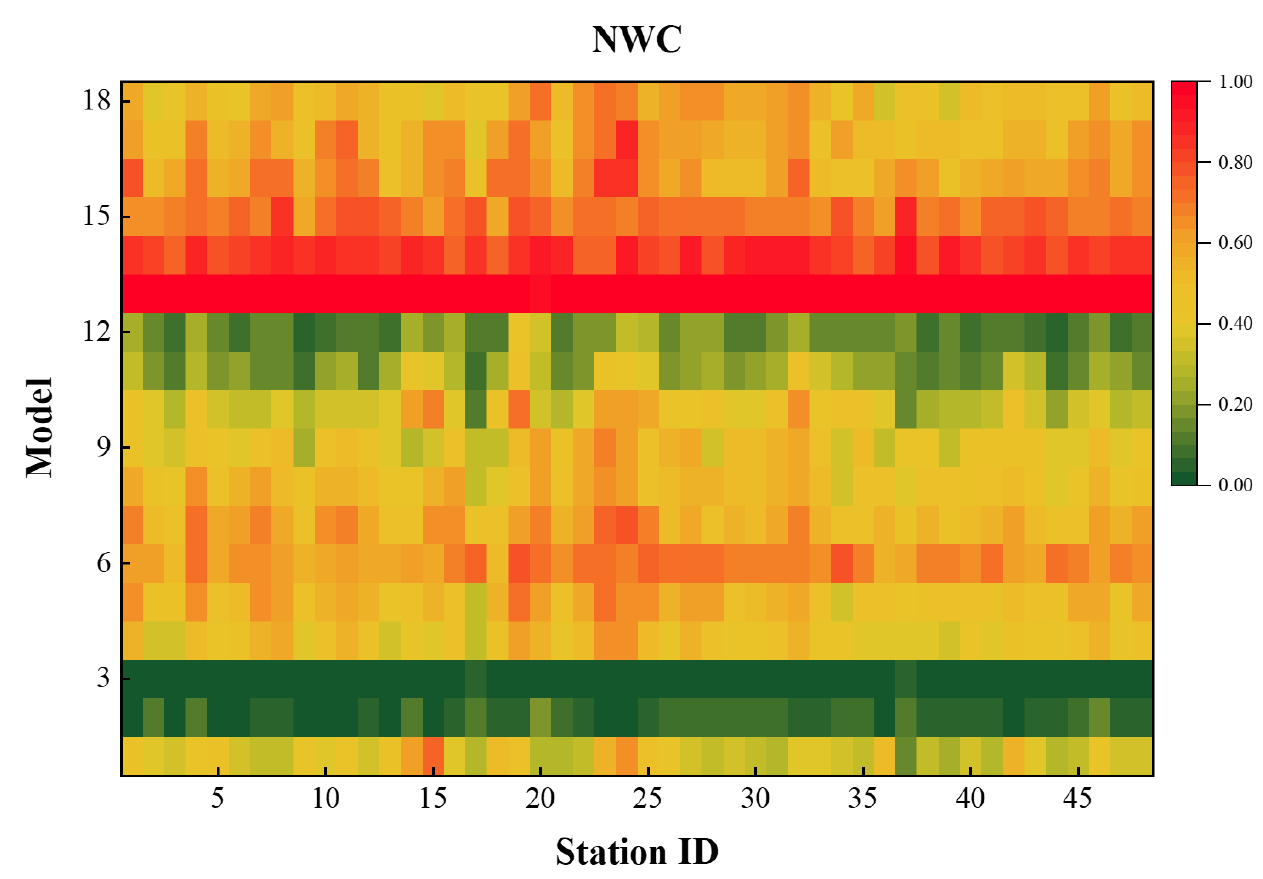
Figure 9. Combined indicator values for each model at all stations in the NEC region. (Model 1–18 in the Y axis represents M5P1, RF1, XGBoost1, M5P2, RF2, XGBoost2, M5P3, RF3, XGBoost3, M5P4, RF4, XGBoost4, M5P5, RF5, XGBoost5, M5P6, RF6, and XGBoost6, respectively, which also applies for Figures